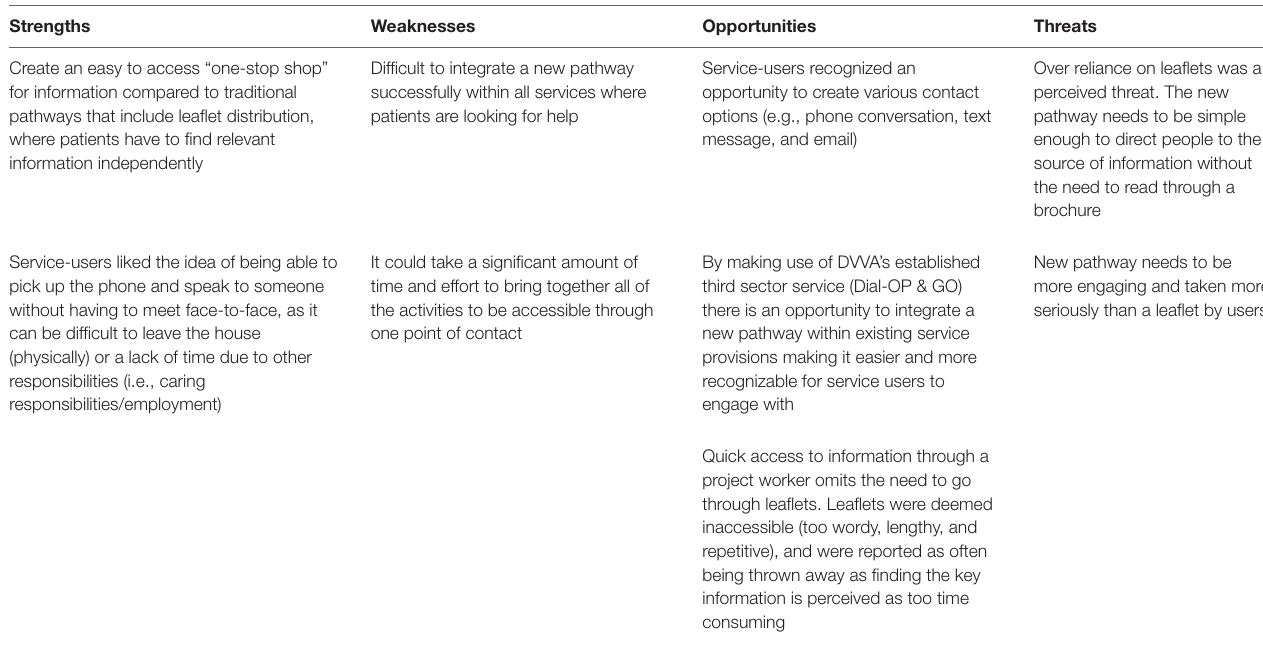
TABLE 2 | Service user SWOT